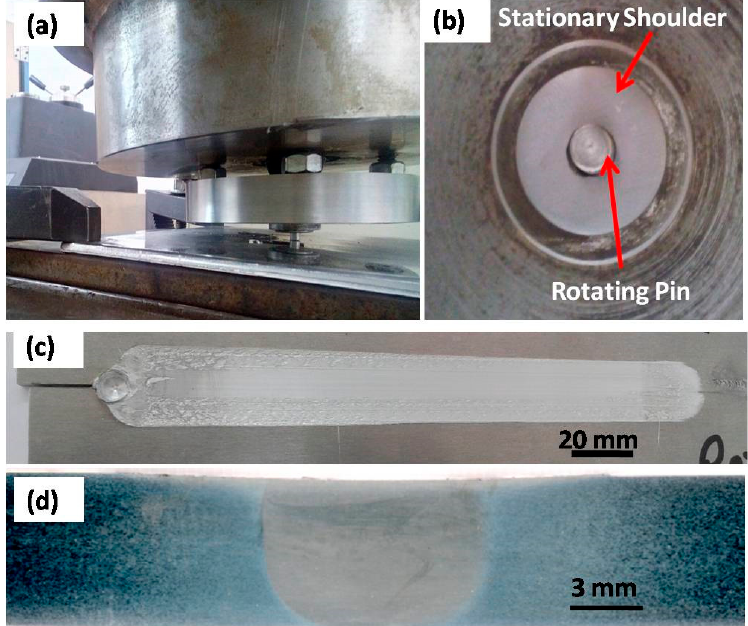
Figure 12. ( a ) External view of SSFSW setup upon plunging. ( b ) Underneath view showing the sta- tionary shoulder and the rotating pin. ( c ) Top view of the SSFSWed AA7075. ( d ) Transverse cross-section macrograph of SSFSWed AA7075 [112].